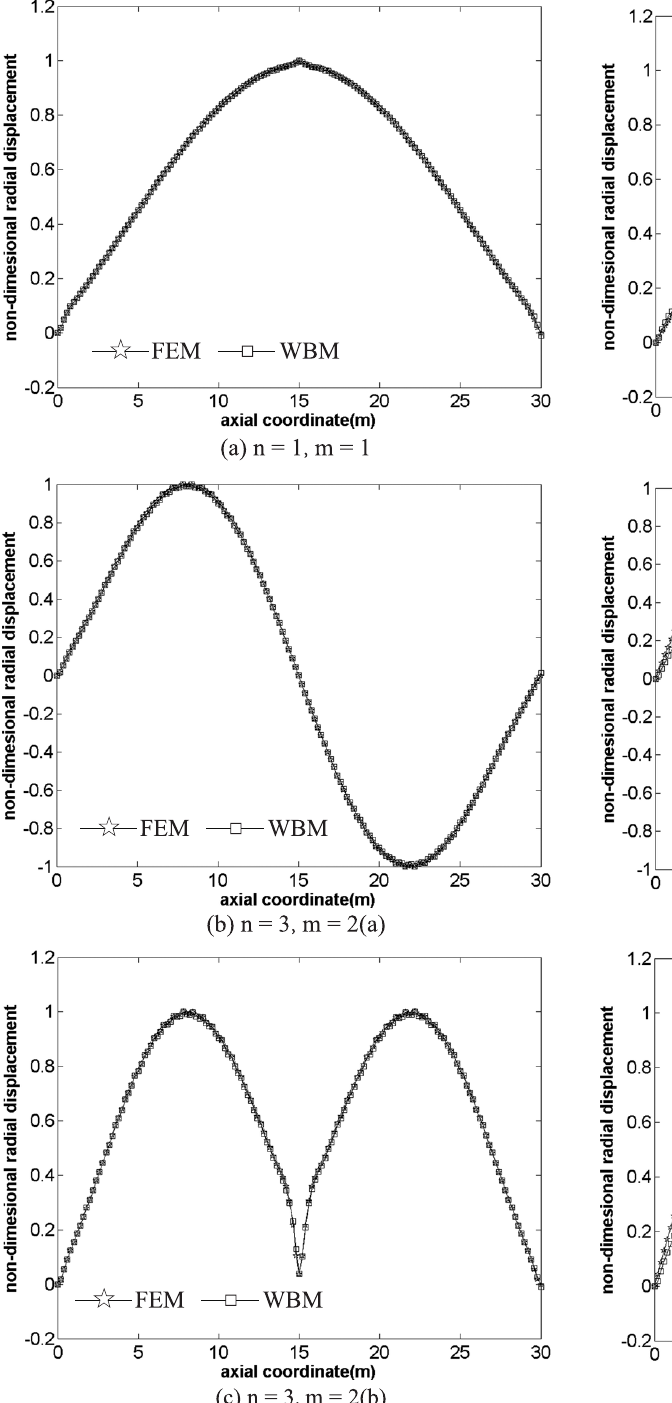
Fig. 7. Comparison of vibration mode shapes of model M1 calculated by FEM and WBM for C-C boundary condition.